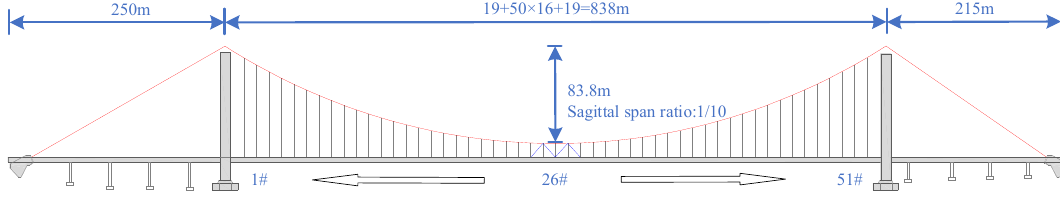
Figure 1. Layout of the prototype bridge.